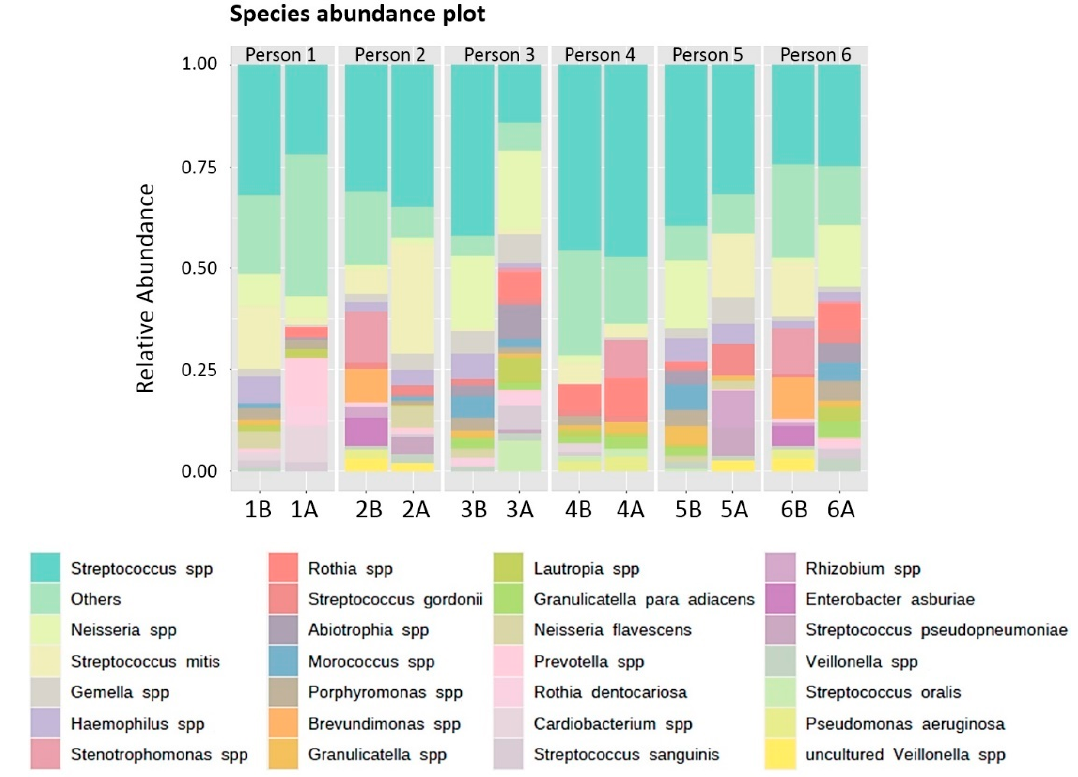
Figure 4. Relative abundance (%) of detected species.